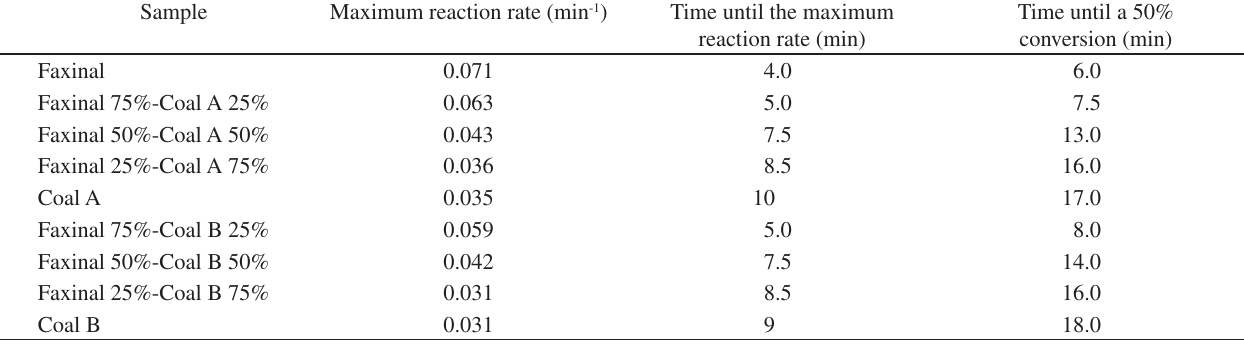
Table 5. Maximum reaction rate, time spent until the attainment of the maximum reaction rate and time until the 50% conversion for the individual coals and their mixtures. Sample